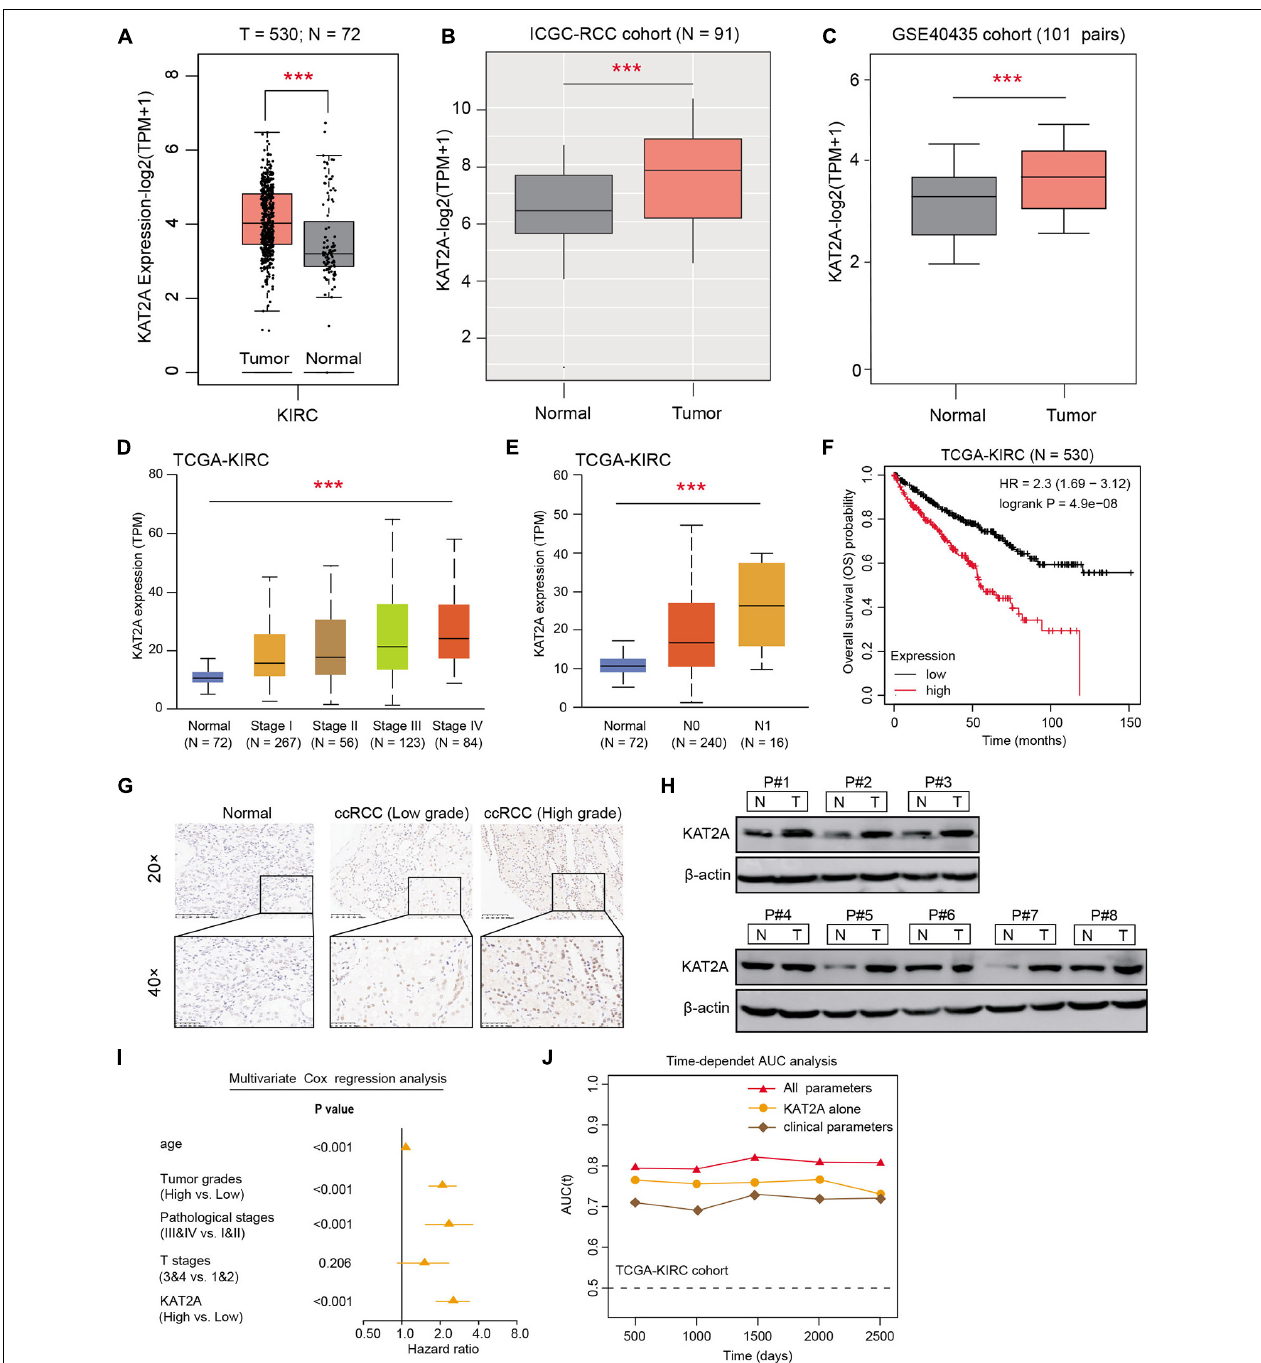
FIGURE 1 | High KAT2A was an independent risk factor in renal cell carcinoma. (A–C) Public data analysis revealed that KAT2A was significantly higher in the RCC tumor samples versus normal tissues in the TCGA-KIRC cohort, ICGC-RCC cohort, and GSE40435 dataset. (D,E) Correlation analysis suggested that KAT2A expression levels were positively associated with advanced pathological stages ( P < 0.0001) and lymph nodes metastasis ( P < 0.0001). (F) Kaplan-Meier analysis indicated that patients with high KAT2A levels suffered from worse survival outcomes versus those with low KAT2A levels (Log-rank test P < 0.0001). (G) Representative immunohistochemical staining for KAT2A in RCC (low-grade and high-grade) and adjacent normal kidney tissues. (H) The protein levels of KAT2A were further assessed in RCC fresh tissues and matched normal kidney tissues through Western blotting ( N = 8 pairs). (I) Multivariable analyses were conducted in the RCC cohort and illustrated by forest plot. All bars correspond to 95% CIs. (J) The time-dependent receiver operating characteristic (ROC) analysis for KAT2A risk scores, clinical parameters, and the combined all variables. *** P < 0.001.